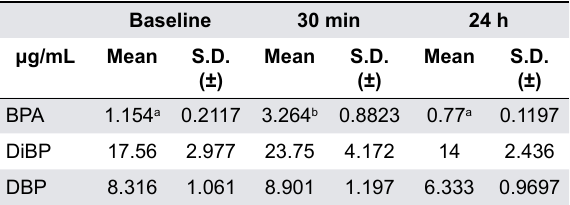
Table 2- Analysis of levels of BPA, DiBP, and DBP in the saliva of children using spurs as a treatment for the anterior open bite. A total of 22 children participated in this study. No statistical difference in the amount of leached DiBP and DBP was detected during the periods of baseline, 30 minutes, and 24 hours after bonding the spur with the orthodontic adhesive. Friedman followed by Dunn´s Multiple Comparison Test. p<0.05 was considered statistically significant. Different letters mean the statistical difference among